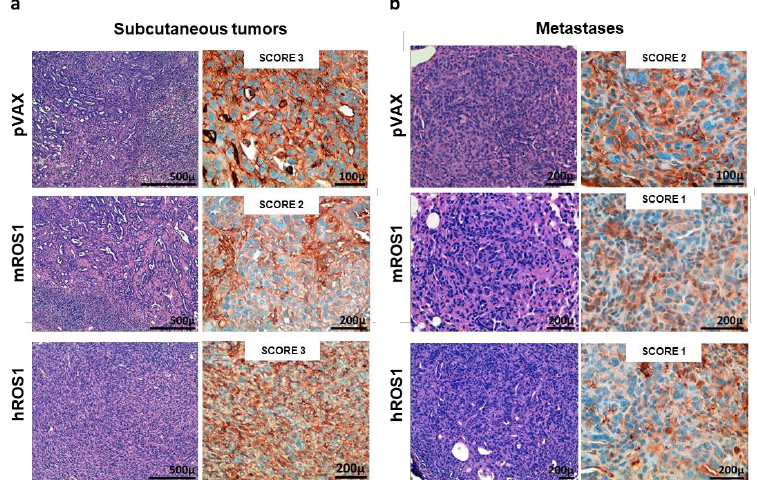
Figure 5. ROS1 expression in transplantable tumors and metastases from wt, and mROS1- and hROS1-vaccinated mice. Representative images of the H&E staining (left panels) and IHC analysis of ROS1 protein expression (right panels) on explanted subcutaneous tumors ( a ) and lung metastases ( b ) from pVAX- (upper panels), mROS- (middle panels), and hROS- (lower panels) electrovaccinated mice. The ROS1 IHC score is indicated in each panel. N = 4 mice were analyzed.